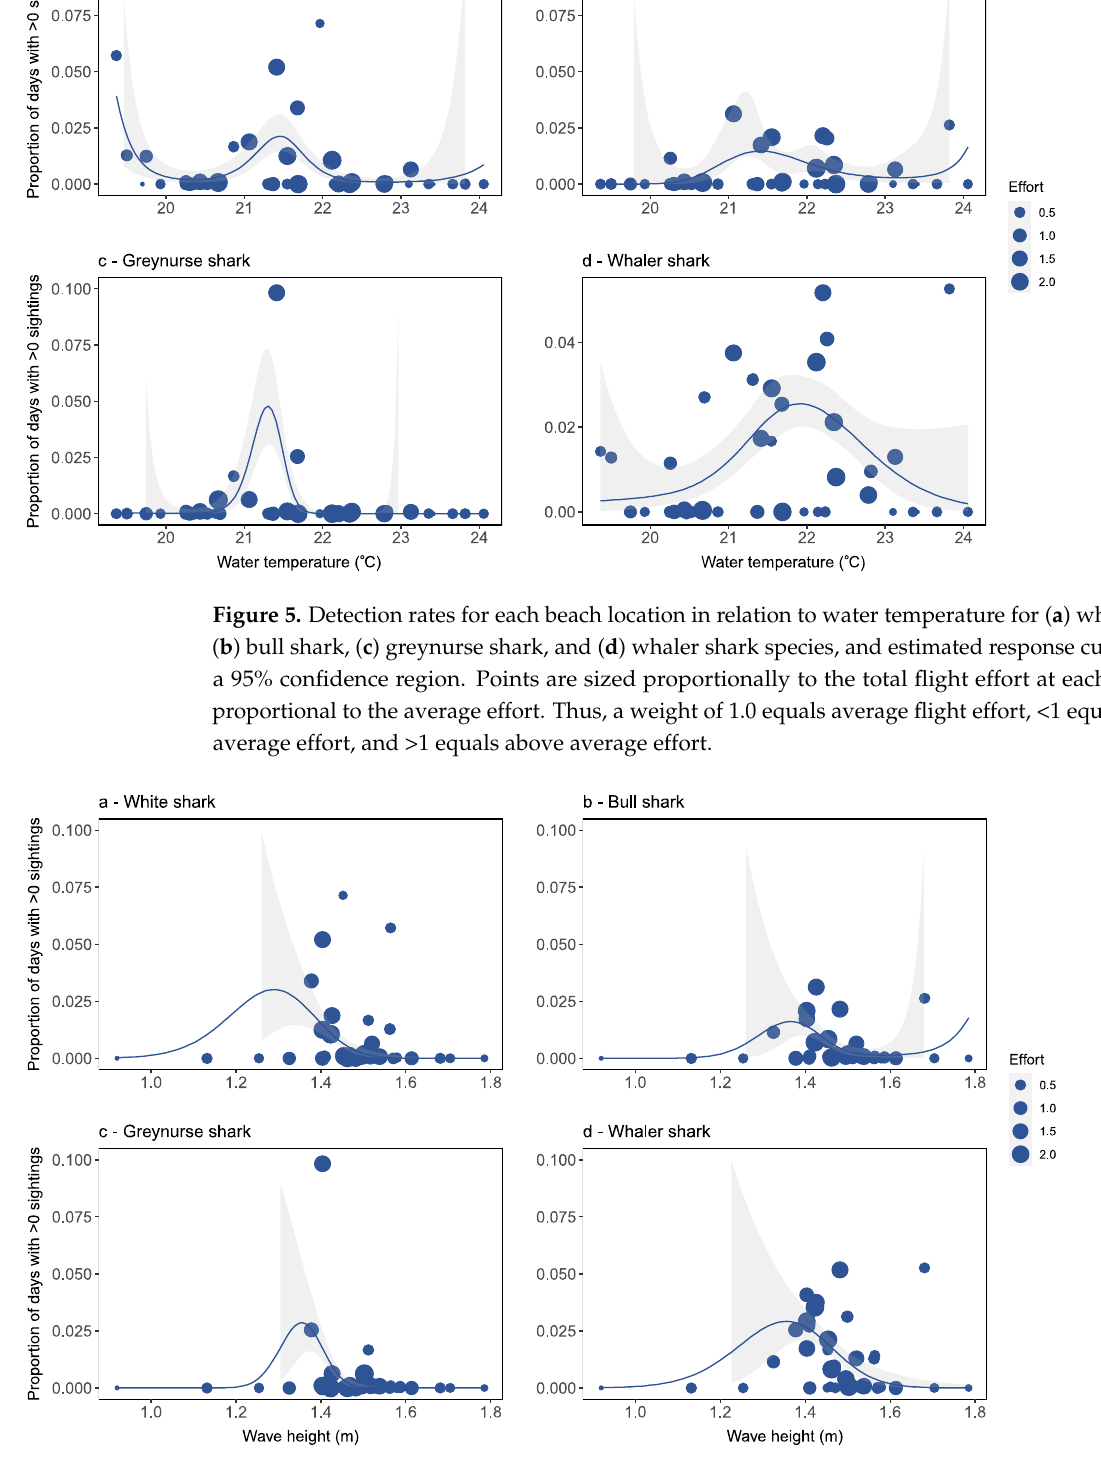
Figure 6. Detection rates for each beach location in relation to wave height for ( a ) white shark, ( b ) bull shark, ( c ) greynurse shark, and ( d ) whaler shark species, and estimated response curves with a 95% confidence region. Points are sized proportionally to the total flight effort at each location proportional to the average effort. Thus, a weight of 1.0 equals average flight effort, <1 equals below average effort, and >1 equals above average effort.